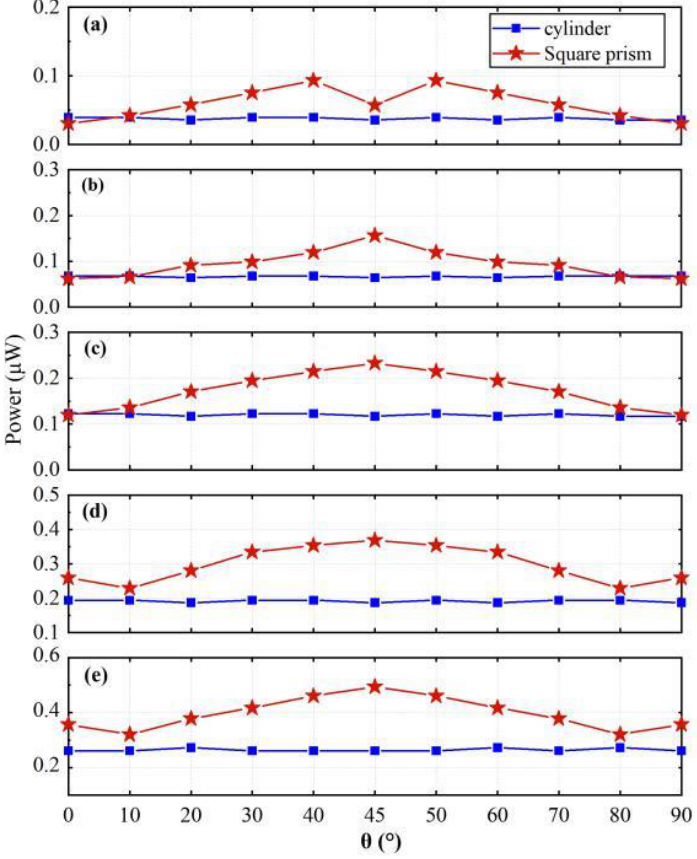
Figure 6. The output power of the harvesters versus angle θ for different wind speeds. ( a ) Wind speed: 4 m/s. ( b ) Wind speed: 5 m/s. ( c ) Wind speed: 6 m/s. ( d ) Wind speed: 7 m/s. ( e ) Wind speed: 8 m/s.